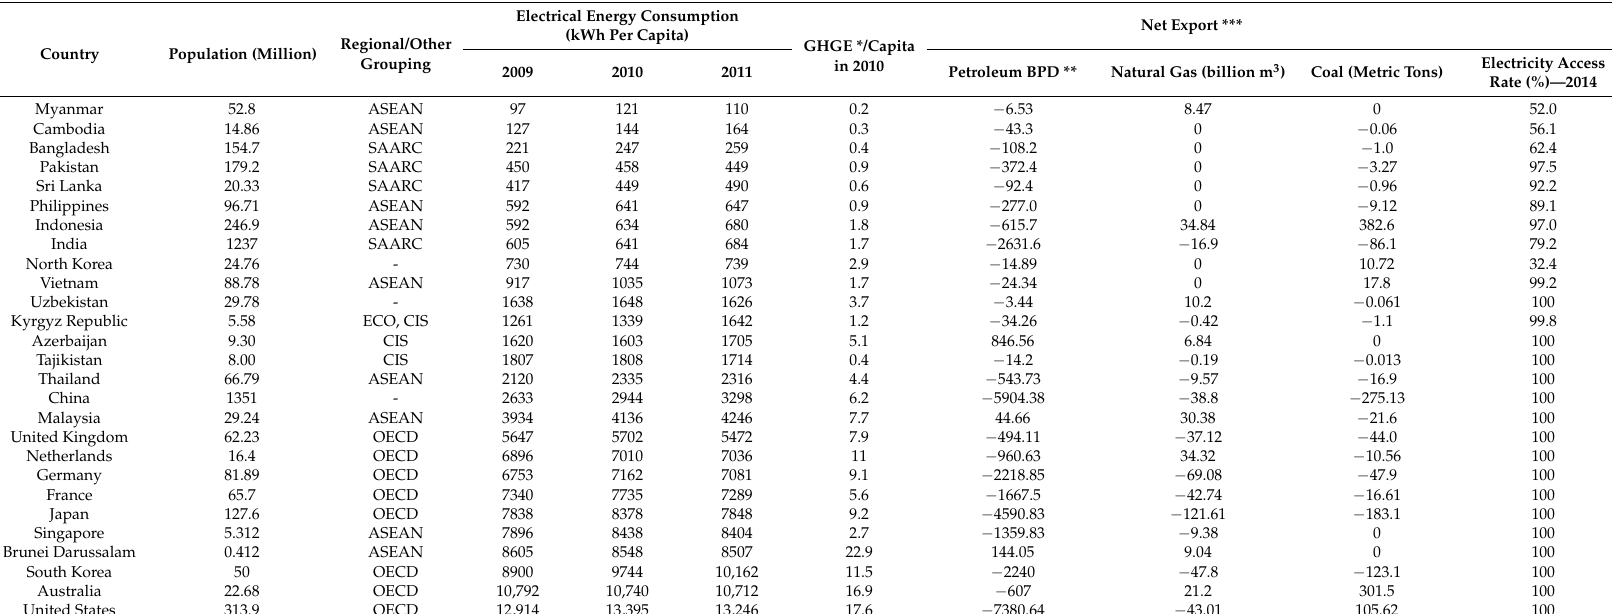
Table 1. Energy Indicators of Asian and several OECD countries